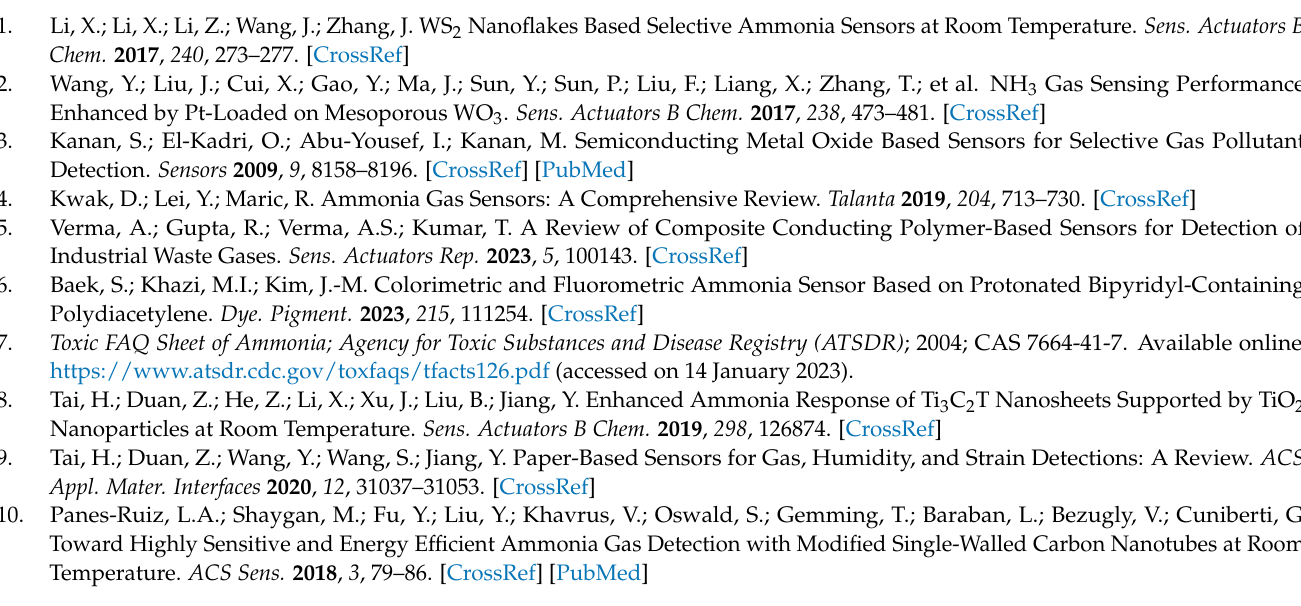
Figure S3: the response time and recovery time of the sensor based on Au-SWCNTs to an exposure of 1 ppm ammonia concentration at 25 ◦